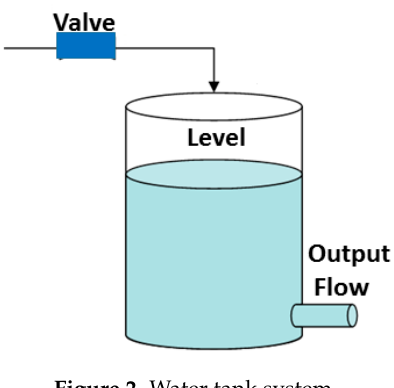
Figure 2. Water tank system.